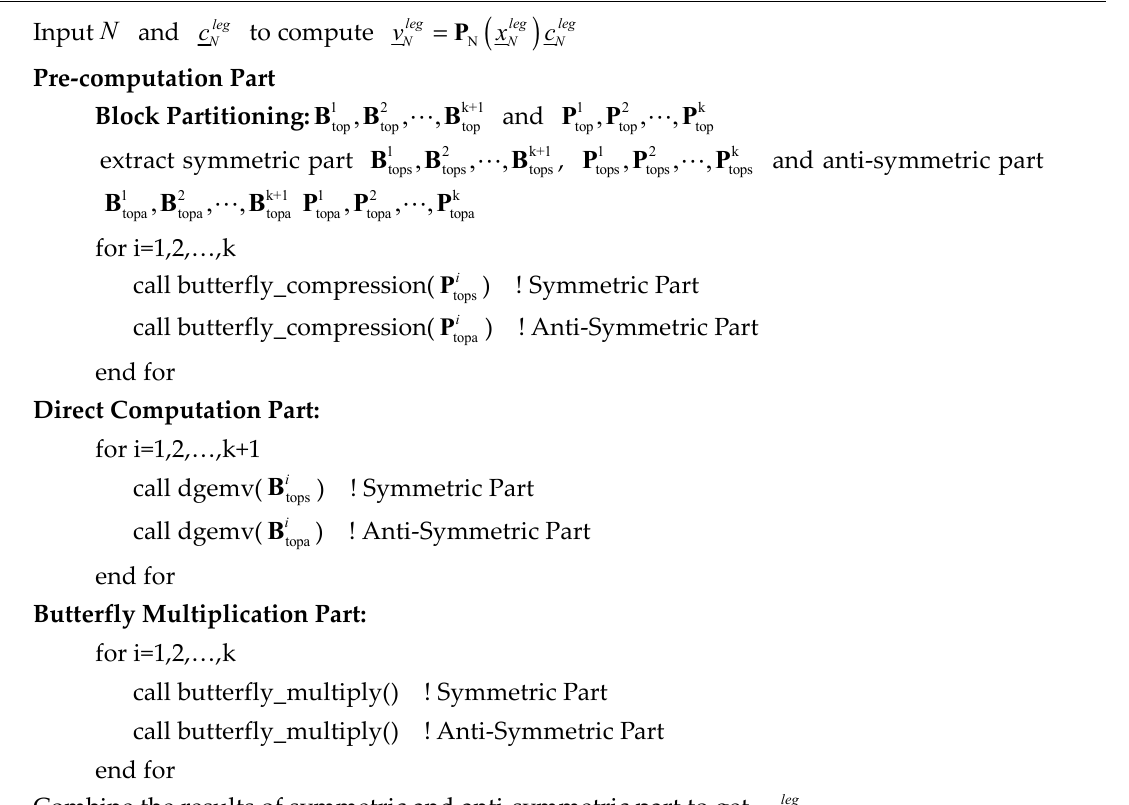
Algorithm 1: Block Butterfly Algorithm for Legendre Transform.